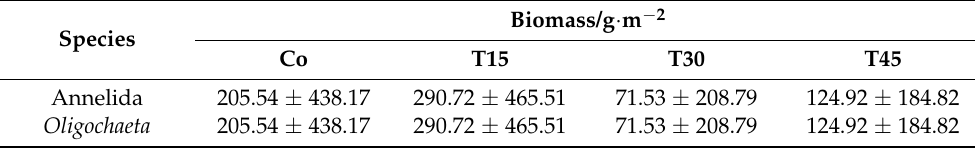
Table A8. Species and biomass of benthos in the enclosures of each treatment group ( n = 3; x ±